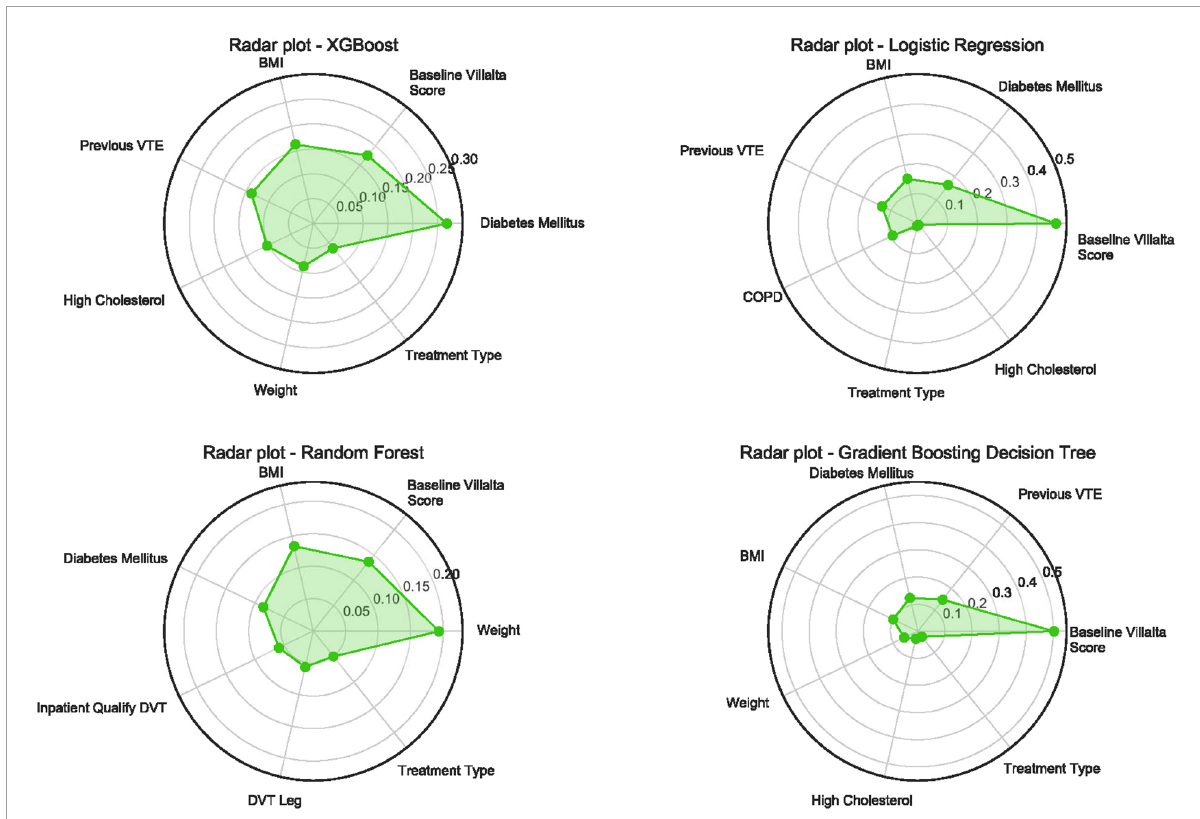
FIGURE2 Radar plot for the seven important predictors of post-thrombotic syndrome in 24 months. Higher value means more importance of the features determined by different ML algorithms. PTS, post-thrombotic syndrome; XGBoost, eXtreme gradient boosting; VTE, venous thromboembolism; BMI, body mass index; COPD, chronic obstructive pulmonary disease; DVT, deep vein thrombosis; ML, machine